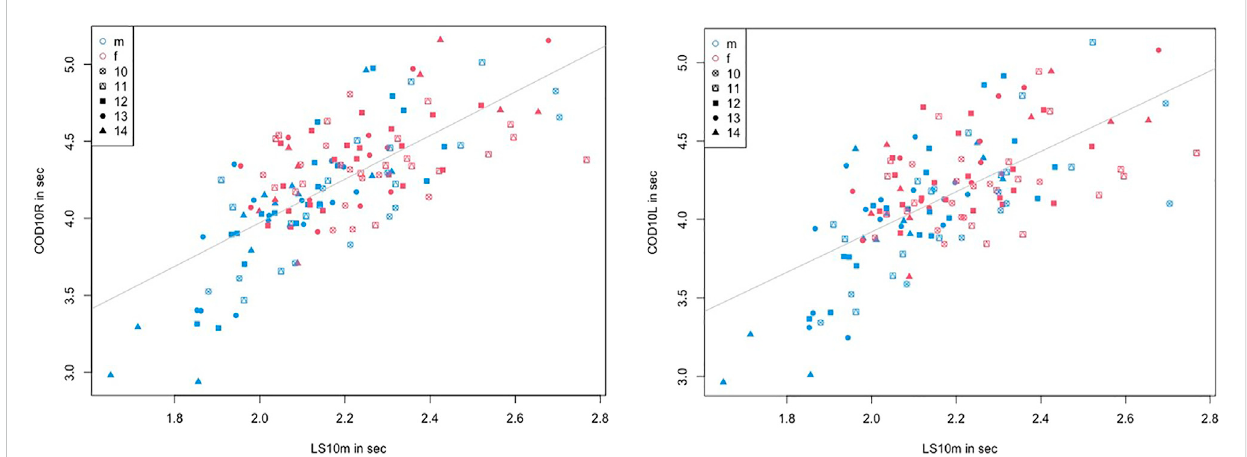
FIGURE 5 Correlation coef fi cients between COD right-turn sprint and linear sprint (10 m) and COD left-turn sprint and linear sprint (10 m) considering age and